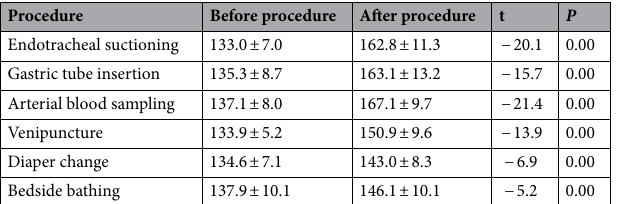
Table 2. Effects of routine manipulation on heart rate in children (times/min, x ±